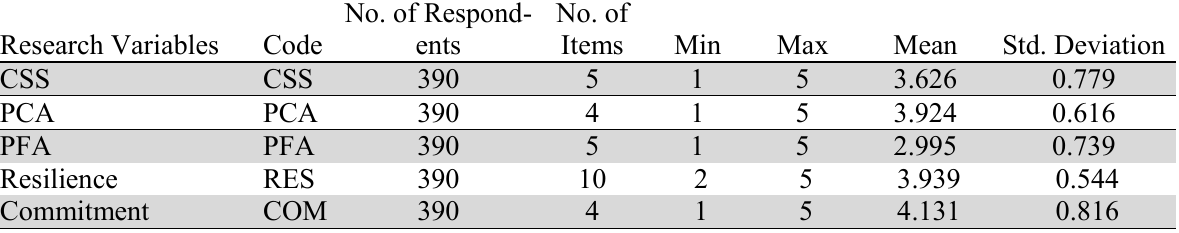
Descriptive Statistics for all Research Constructs of the